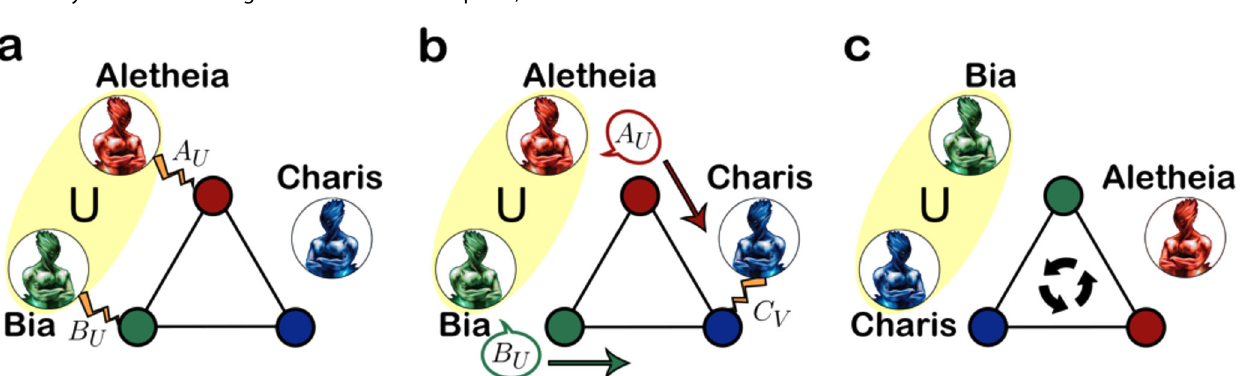
Fig. 3 a – c Diagrammatic representation of the scheme extractable work-based tripartite inseparability. Each panel illustrates one of the steps of the protocol described in the main